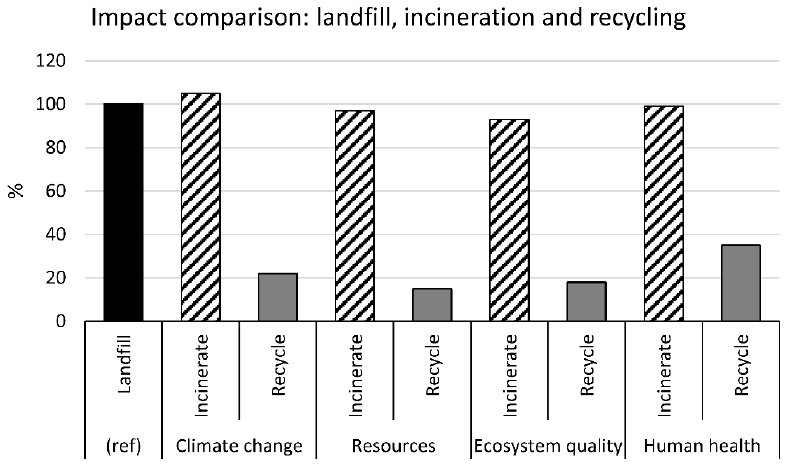
Figure 2. The impact comparison of landfill disposal, incineration and recycling, reproduced from [11].